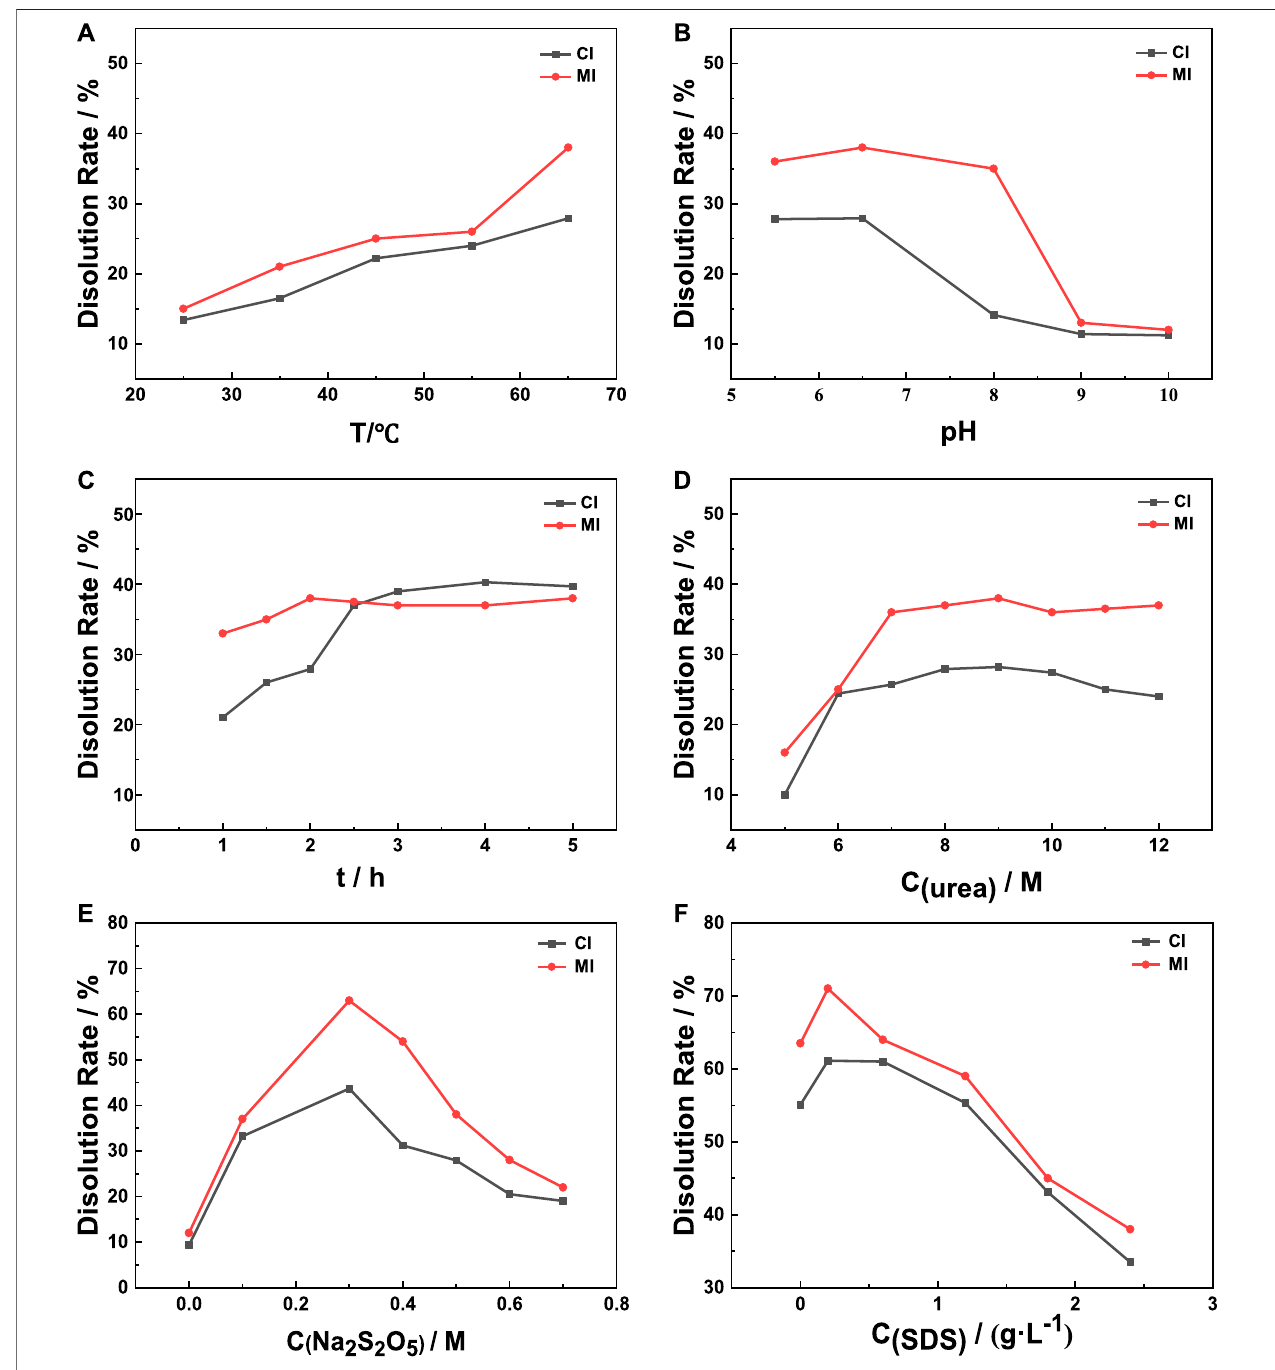
FIGURE 1 | Exploration of the extraction process. (A) T , (B) pH, (C) t , (D) C (urea) , (E) C (Na2S2O5) , (F) C (SDS).